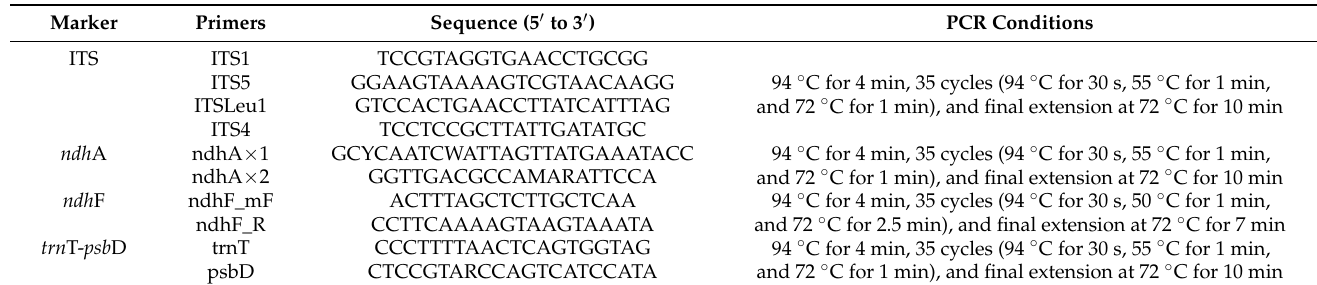
Table 3. List of primers used and PCR